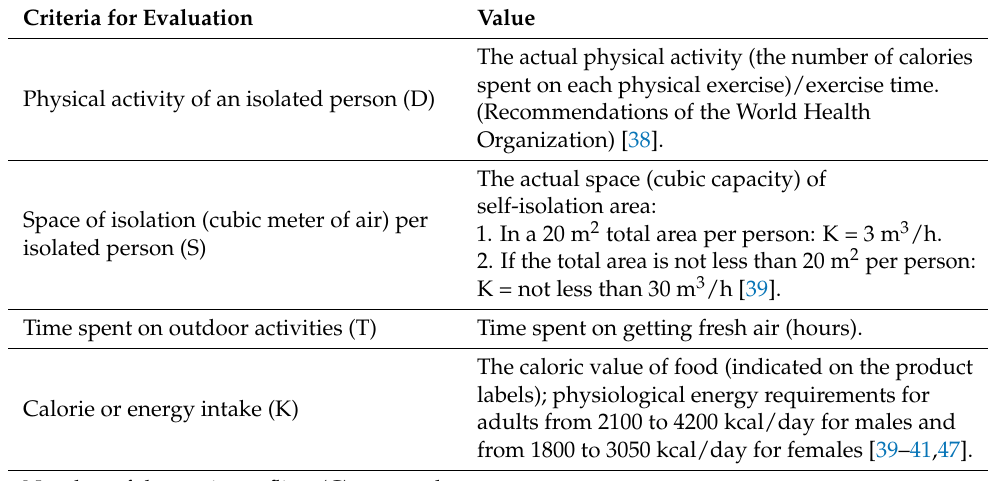
Table 1. The sanitary-hygienic criteria of the hygienic self-isolation index (HISI). Criteria for Evaluation Value The actual physical activity (the number of calories spent on each physical exercise)/exercise time. Physical activity of an isolated person (D) (Recommendations of the World Health Organization) [38].